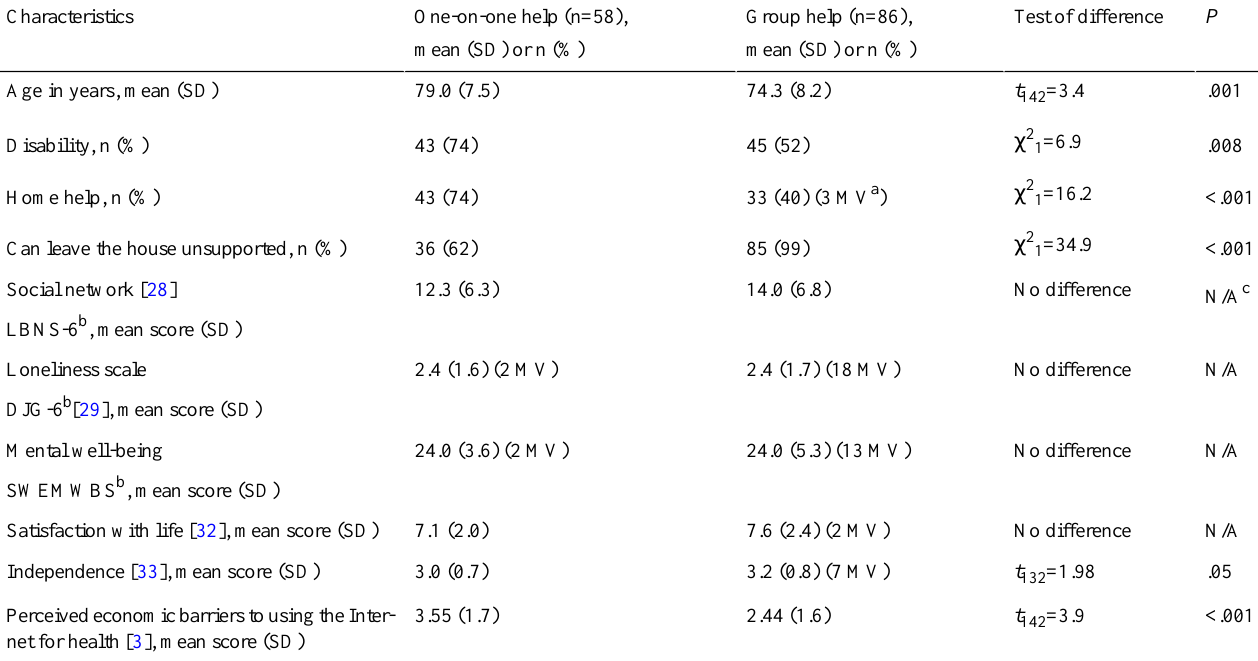
Table 1. Comparison of beneficiaries receiving one-on-one help at home with those due to receive group help.